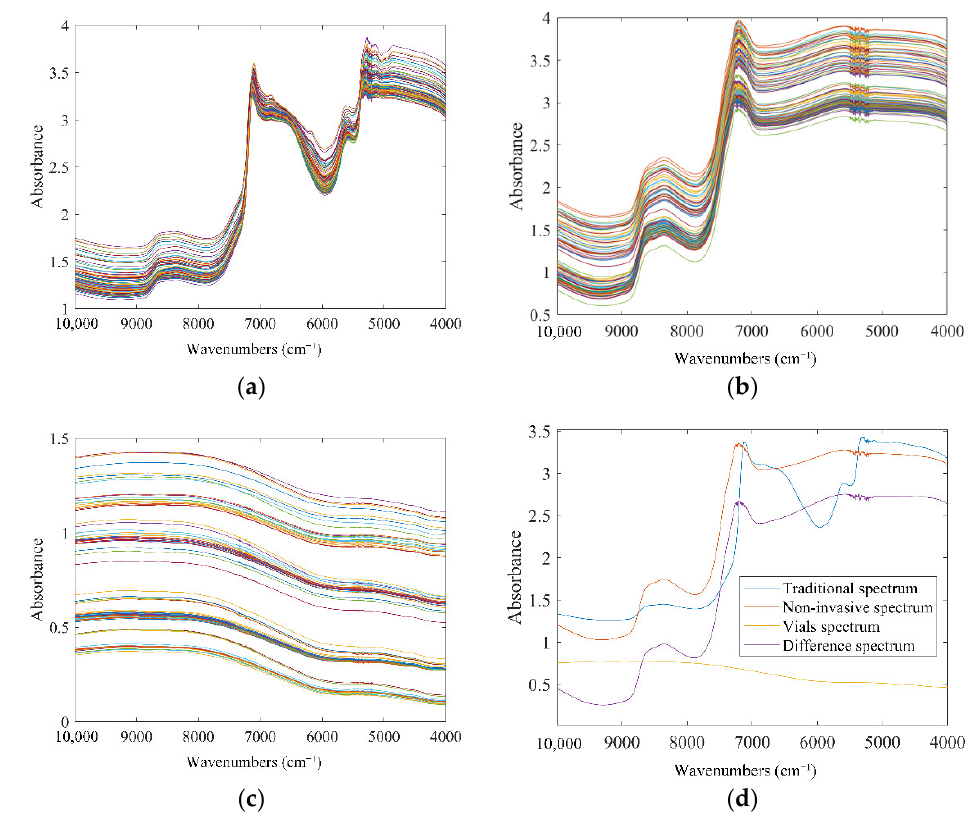
Figure 1. The raw NIR absorbance spectra: ( a ) traditional spectra; ( b ) spectra that penetrates the vial; ( c ) spectra of the vial; ( d ) average spectra.